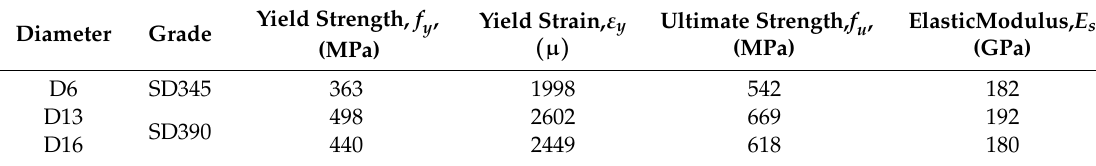
Table 2. Material Test Results for the Reinforcing Bars.